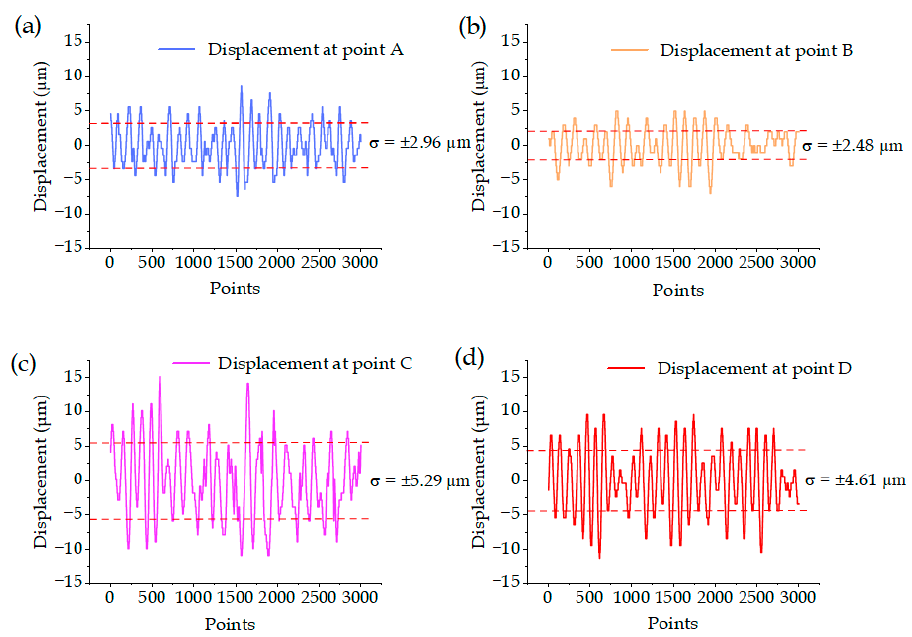
Figure 10. Point displacement vibration diagram of the laser machine: ( a ) vibration displacement diagram of point A; ( b ) vibration displacement diagram of point B; ( c ) vibration displacement diagram of point C; ( d ) vibration displacement diagram of point D.